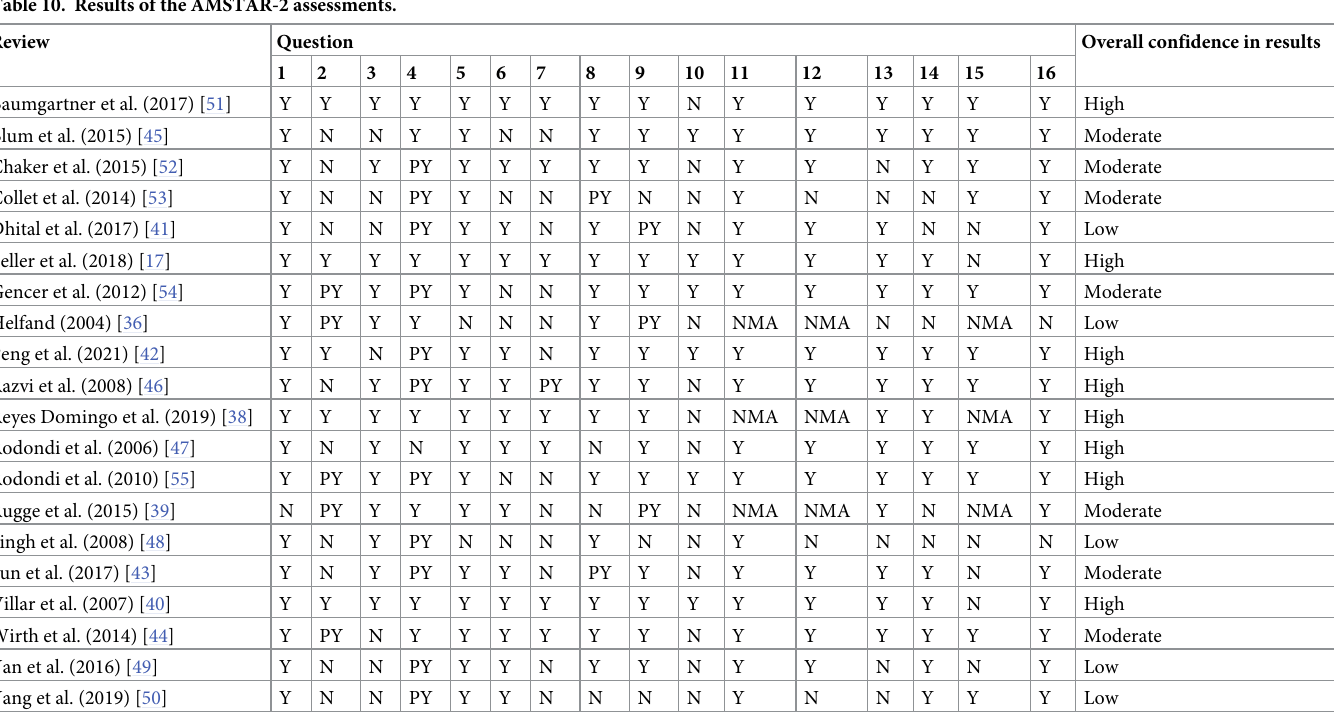
Table 10. Results of the AMSTAR-2